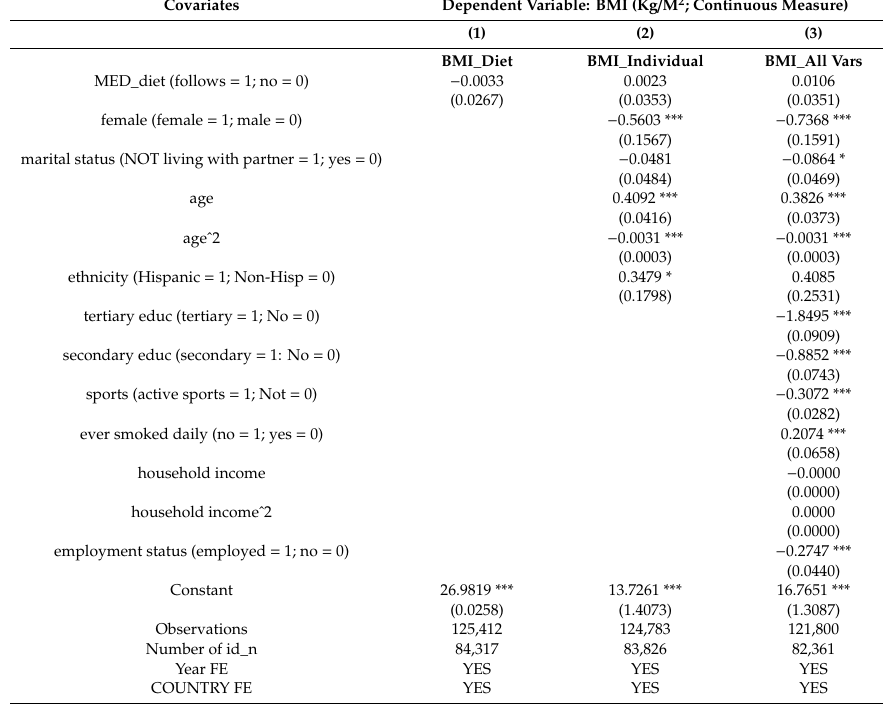
Table 3. Regression analysis relating BMI with the Mediterranean diet, individual and socio-demographic characteristics and lifestyle